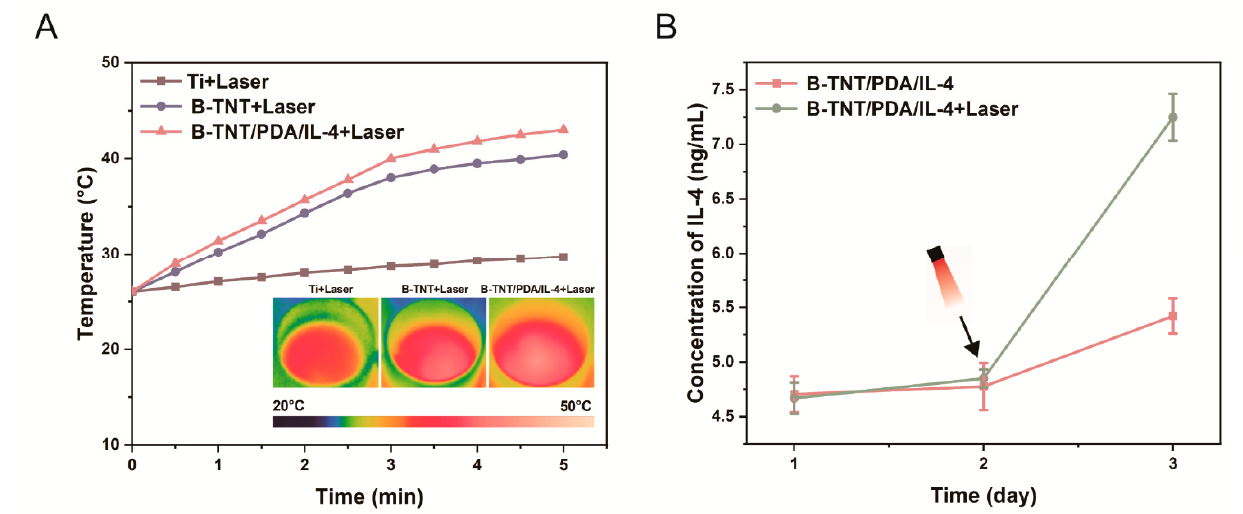
Figure 5. ( A ) Temperature changes in different surfaces irradiated by laser. ( B ) The amount of IL-4 released in B-TNT/PDA/IL-4 substrates with or without laser irradiation.